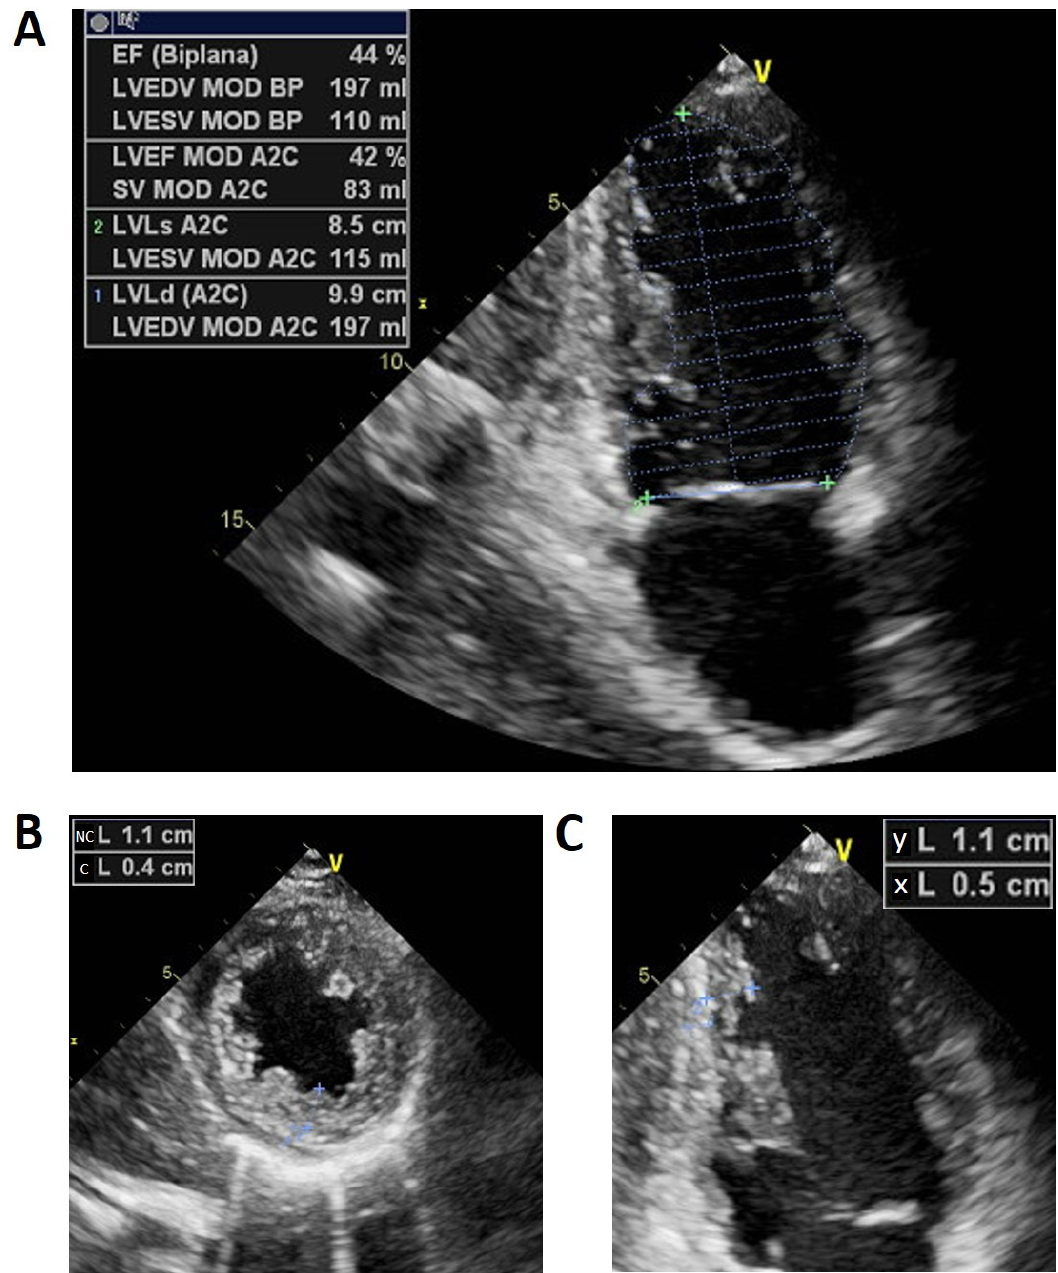
Figure 1. ( A ) Apical two-chamber view showing left ventricle (LV) dilatation (end-diastolic volume indexed 105 mL/m 2 and end-systolic volume indexed 58 mL/m 2 ), with a reduced ejection fraction (EF) (44%, biplane). ( B ) Parasternal short axis of LV during the systole phase showing a compact epicardial layer (C) and noncompacted endocardial layer (NC) mainly in the mid apical inferior and inferolateral left ventricle with prominent trabeculations and a maximal end systolic NC/C trabecular ratio > 2 (criteria reference: [15]). ( C ) Ratio of the distance from the epicardial surface to the trough of the trabecular recess (X) to the distance from the epicardial surface to the peak of the trabeculation (Y) with a ratio ≤ 0.5.